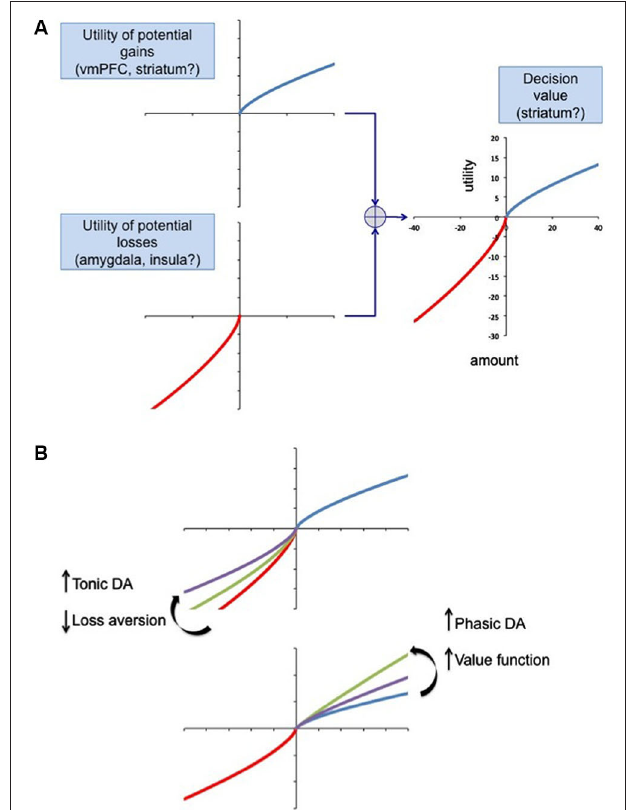
FIGURE 3 | A model of decision-making based on prospect theory. (A) The utility of potential gains and losses is given by the following equation: u ( x ) = ( x ) α for potential gains and u ( x ) = − λ · ( − x ) β for losses (Kahneman and Tversky, 1979). When the loss aversion parameter λ is greater than 1 the function is steeper in the loss domain, implying loss aversion. In this model the utility of gains and losses is computed by different neural networks and combined at some point. We list regions that may be implicated in the calculation. (B) Dopamine may influence the shape of the utility function for gains and losses, by affecting any of the parameters α , β or λ to regulate the degree of loss aversion. Tonic and phasic dopamine may modulate gain and loss calculation via the direct and indirect basal ganglia pathways ( Figure 2 ). The balance of tonic and phasic dopamine signaling could regulate the balance between action selection and inhibition, regulating the current level of loss